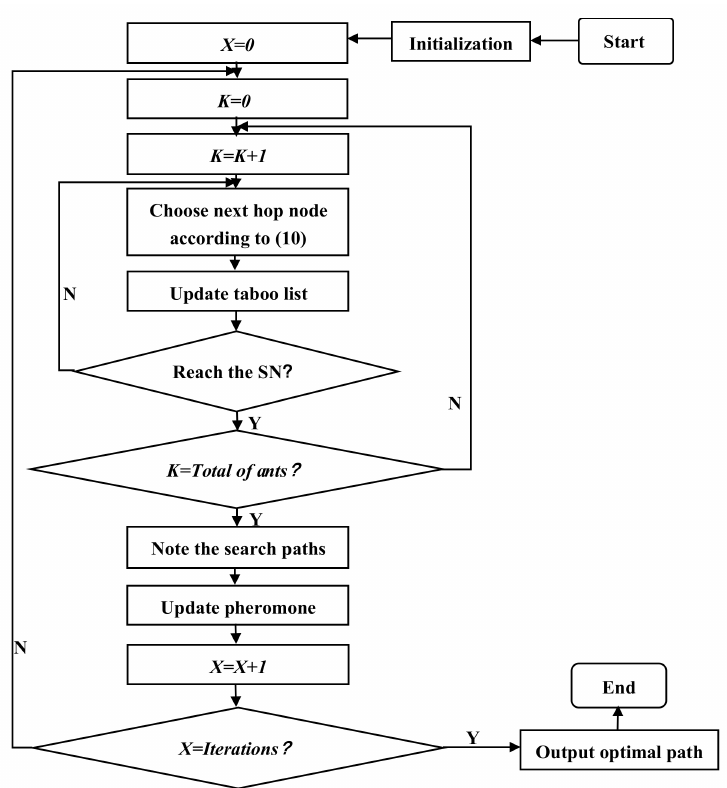
Figure 3. The process of the improved ant colony optimization (ACO) algorithm.